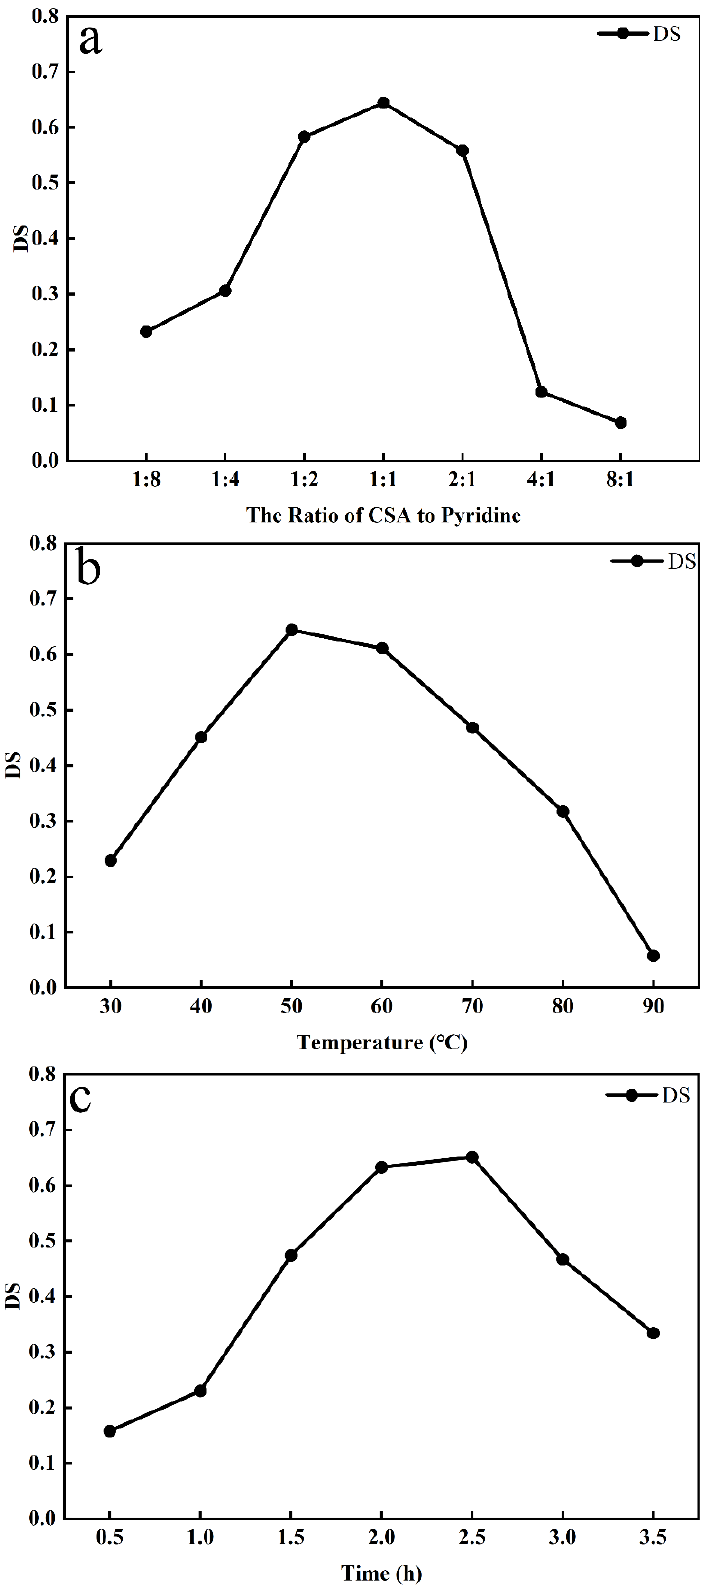
Figure 2. The effects of various parameters on DS: ( a ) ratio of CSA to Pyr; ( b ) temperature; ( c ) reac- tion time.